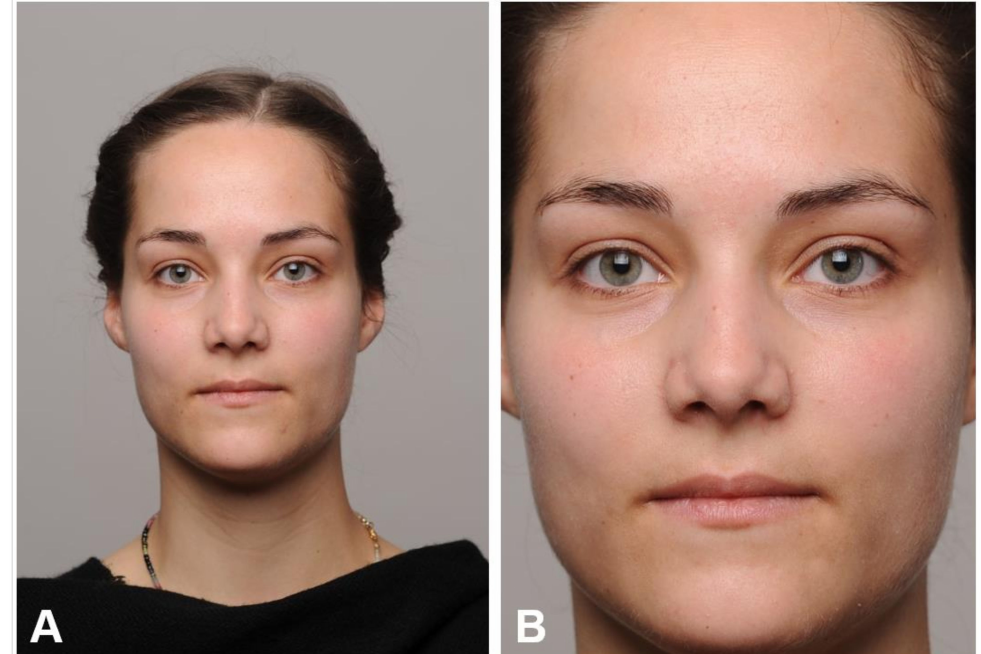
Figure 3. Example picture to represent photographs taken of each walker in an original ( A ) and cropped version ( B ). The latter was used for the ratings. For reasons of data protection, no photograph of a walker is shown here, but of one of the authors (FD) agreed to have her picture published here. Cropping, lighting, and camera settings correspond to those of the walkers. © The